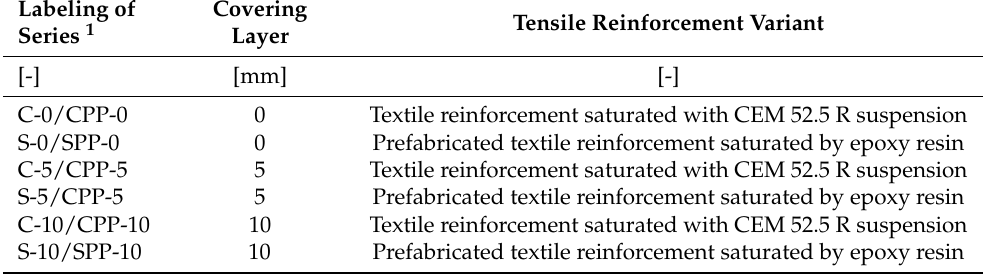
Table 2. Description of the test